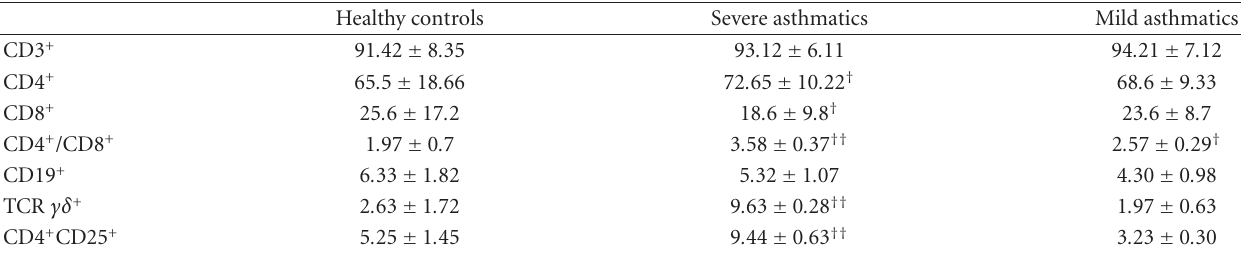
Table 2: Percentages of lymphocyte subsets and CD4/CD8 ratio in the induced sputum of healthy control, mild asthmatic, and severe asthmatic patients.